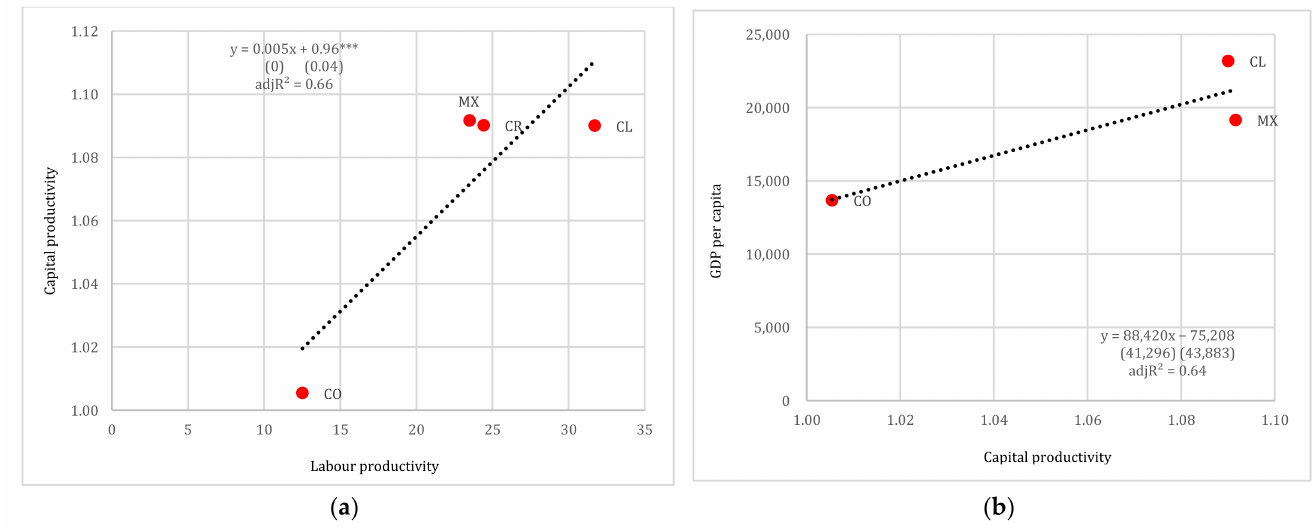
Figure 8. ( a ) Labour productivity vs. capital productivity and ( b ) capital productivity vs. GDP per capita (in USD pps), Latin America. Note: Standard errors reported in parentheses. *** denotes 1% levels of statistical significance.